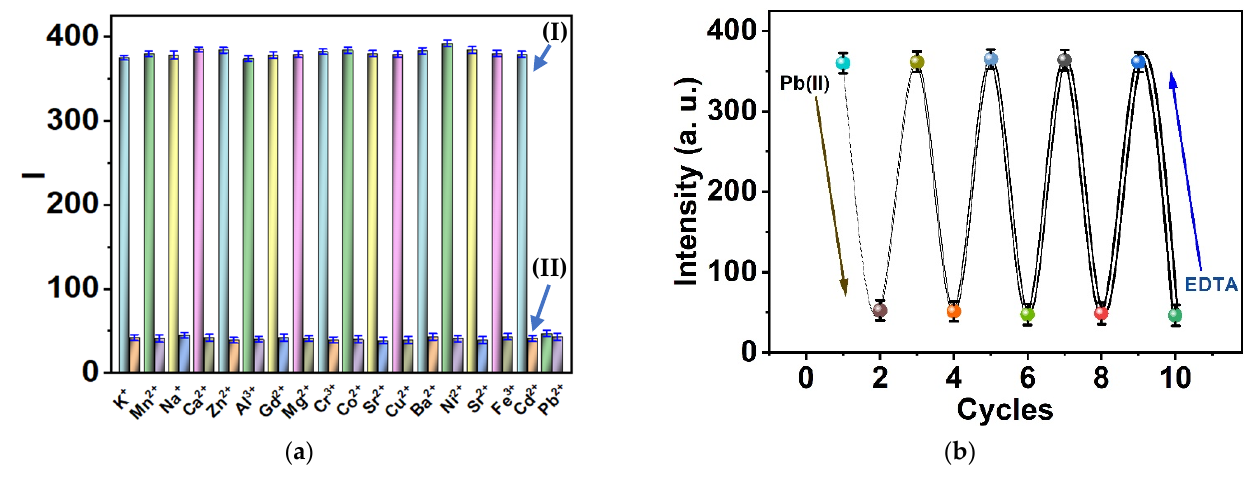
Figure 7. ( a ) Pep-CuNCs’ fluorescent intensities in the presence of (I) different metal ions and (II) different metal ions and Pb(II); ( b )The recovery test based on EDTA solution; ( n = 3).